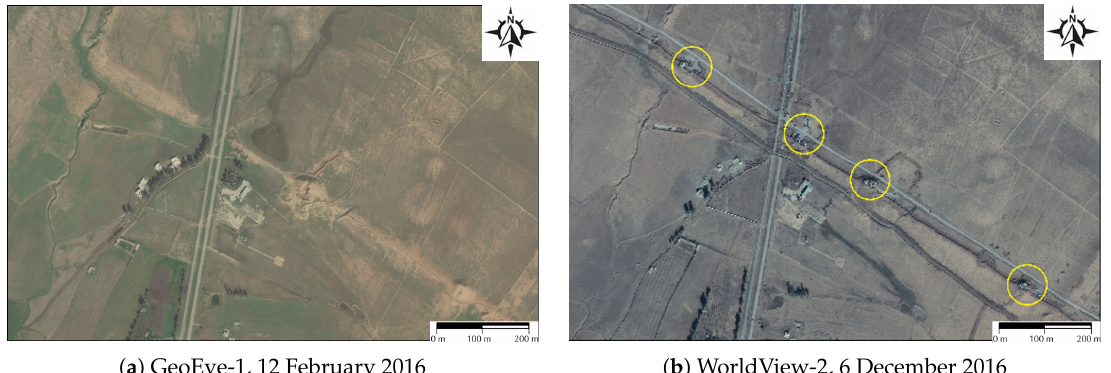
Figure 7. Construction damage type related to new defence position including strongholds, revetments and trenches directly over cultural heritage sites (highlighted in yellow) c (cid:13) DigitalGlobe.